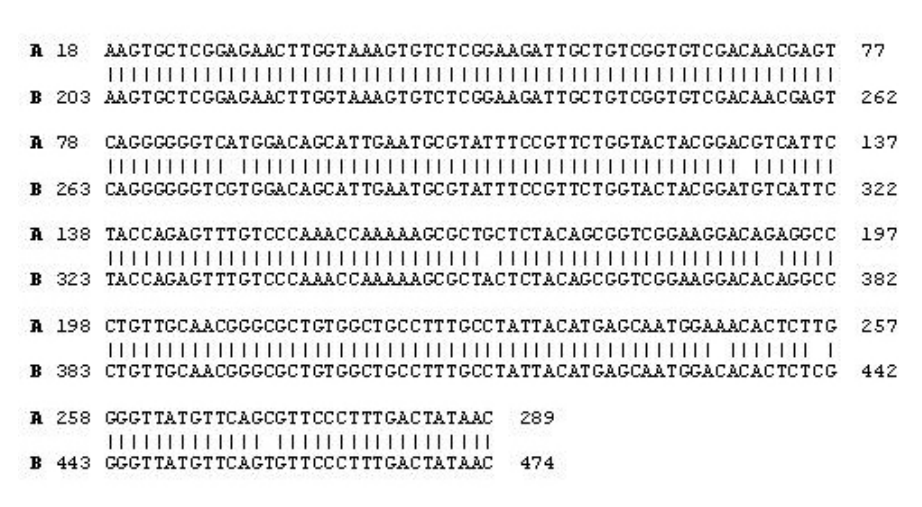
Figure 8. Comparison of nucleotide sequences of the Heteractis magnifica cytolysin from ( A ) Indian and ( B ) Singaporean waters. Sequence comparison showed changes in seven positions (273, 315, 354, 377, 441, 433 and